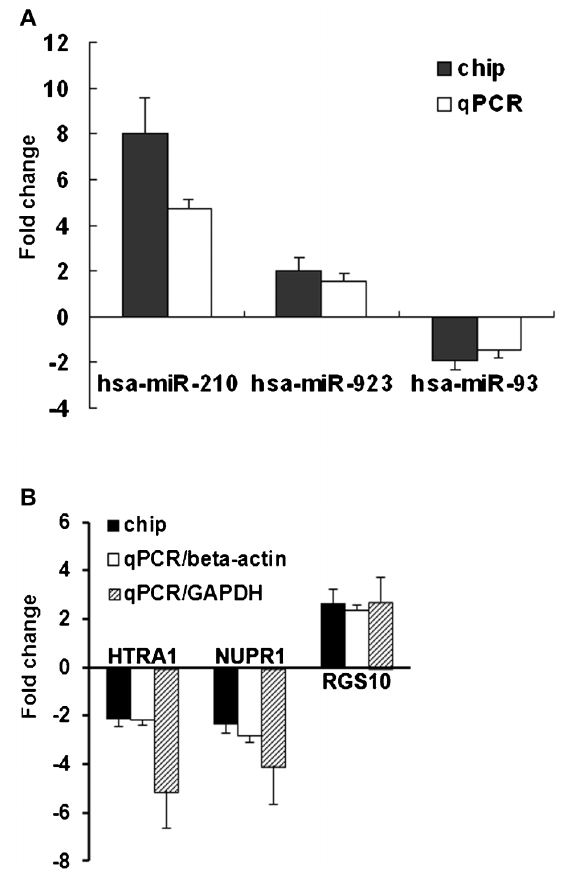
Figure 4. Real-time reverse transcriptase-polymerase chain reaction (RT-PCR) validating that the expressions of has-miR- 210, has-miR-923, and regulator of G-protein signaling 10 (RGS10) are up-regulated and those of has-miR-93, high- temperature requirement protein A1 (HTRA1), and nuclear protein 1 (NUPR1) are down-regulated in Hep-2/v cells compared to Hep-2 cells. The relative levels of has-miR-210, has-miR-923, and has-miR-93 ( A ), as well as HTRA1, NUPR1, and RGS10 transcripts ( B ) in Hep-2 and Hep-2/v cells were determined by real-time RT-PCR. The relative expression levels of each microRNA were determined using U6 smalll nuclear RNA as an internal control, whereas those of each mRNA were determined using both beta-actin (q-PCR/beta-actin) and glyceraldehyde-3- phosphate dehydrogenase (q-PCR/GAPDH) as endogenous controls. The fold-changes were calculated by dividing the expression level of each gene of interest relative to